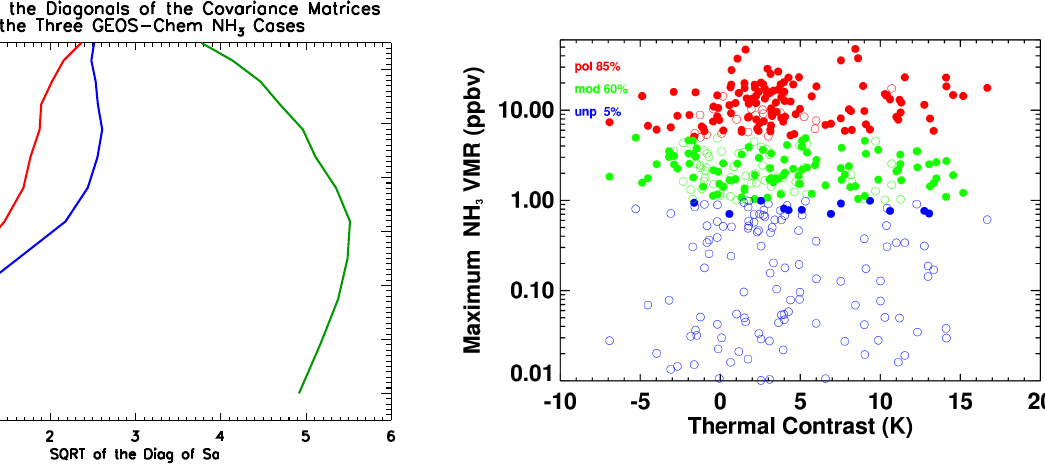
Fig. 6. Scatter plot of the maximum NH 3 VMR in each profile as a function of thermal contrast for the same simulated data set used in Fig. 5. The filled circles indicate spectra with NH 3 SNR ≥ 1 whereas the open circles correspond to NH 3 SNR < 1. The colors correspond to unpolluted (blue), moderately polluted (green), and polluted (red) NH 3 profiles. Also provided are the percentage of cases for each polluted condition that meet the SNR > 1